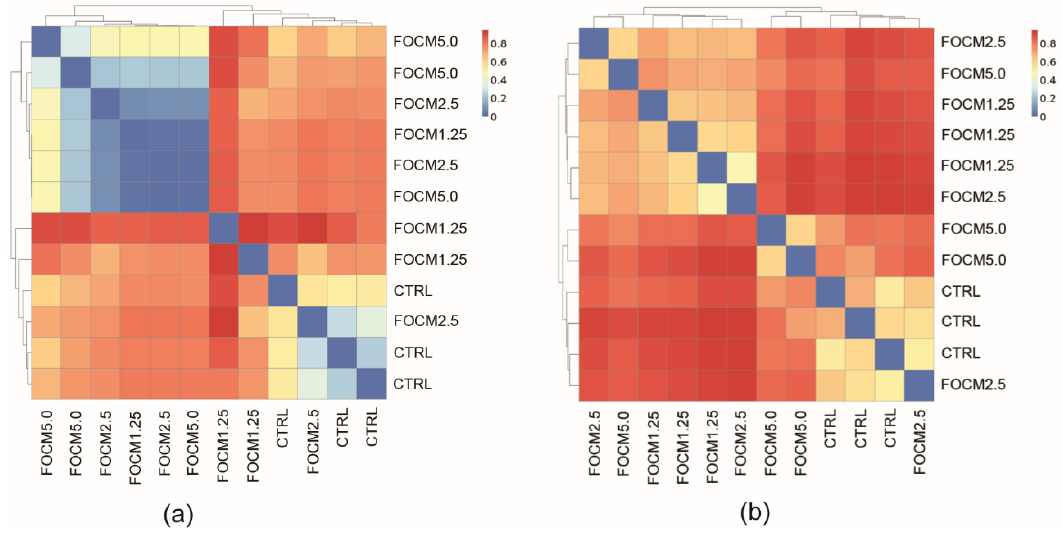
Figure 7. Comparative analysis of the ileal contents across the samples. The beta diversity index of the ileal contents from the basal diet as control (CTRL), basal diet plus 1.25% of FOCM (FOCM1.25), basal diet plus 2.5% of FOCM (FOCM2.5), and basal diet plus 5.0% of FOCM (FOCM5.0) based on weighted UniFrac metrics ( n = 3) ( a ) and unweighted UniFrac metrics ( n = 3) ( b ).